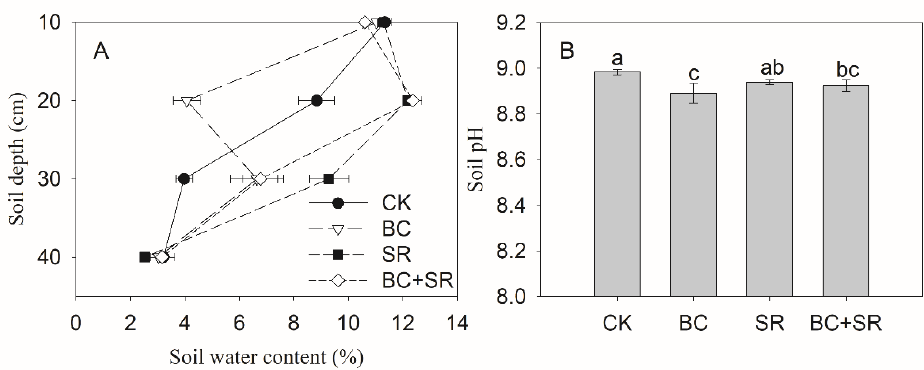
Figure 4. Effect of different soil types on soil water content ( A ) and soil pH ( B ). CK, sand only; BC, biochar; SR, sand and soft rock; BC + SR, sand, biochar, and soft rock. Data are shown in mean ± SD. Different letters indicate significant differences ( p < 0.05).